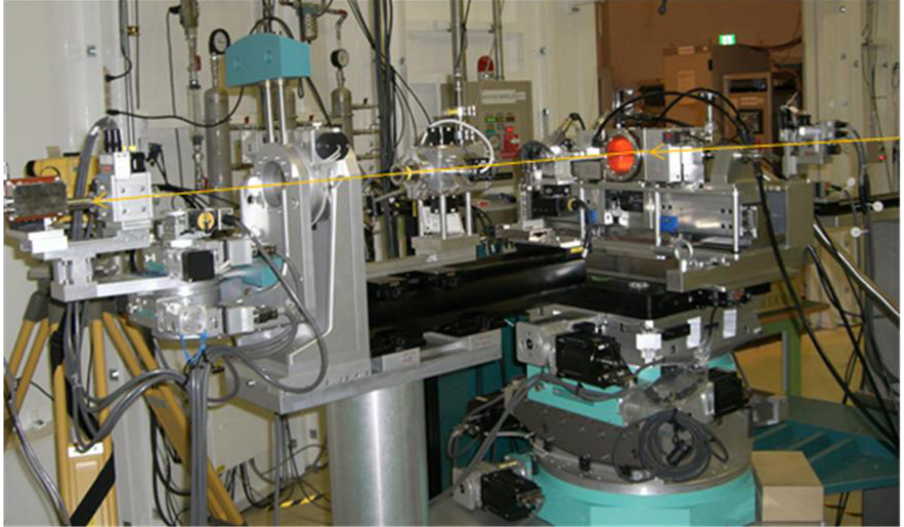
Figure 3. Photograph of the experimental setup.